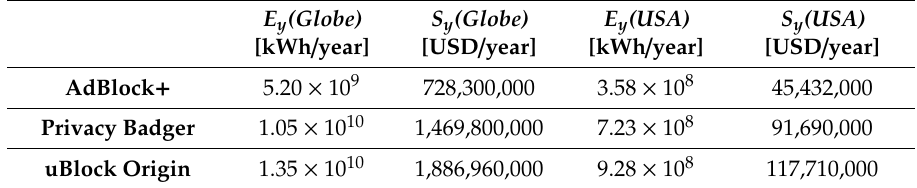
Table 4. Electrical energy conserved and consumer electric bill savings per year from the use of open source ad blockers in the world and the United States during rapid Internet use for AdBlock + , Privacy Badger, and uBlock